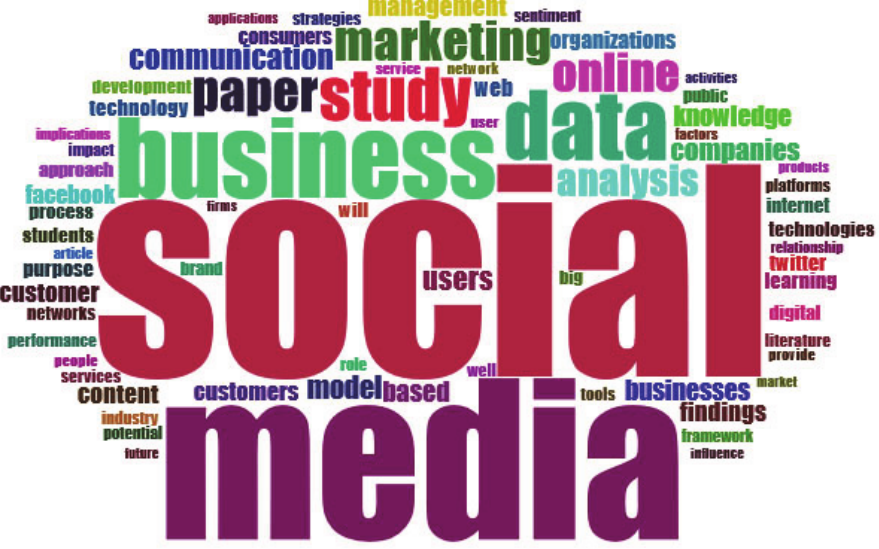
Fig. 6. The frequency of the keywords used in different paper